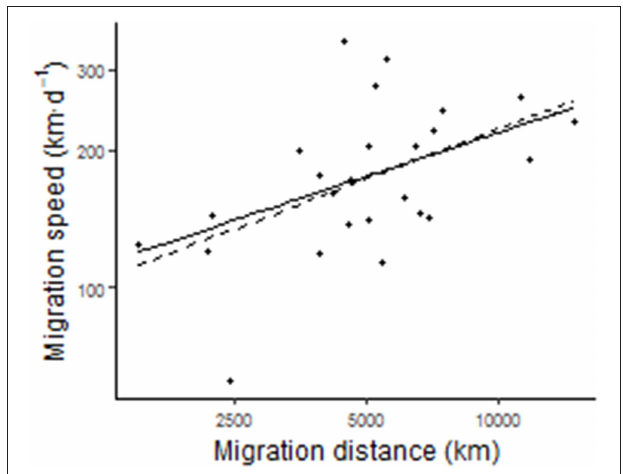
FIGURE 8 | Songbird species with longer migrations have faster migration speeds. The phylogenetically-controlled regression line is shown (solid line) in addition to the least squares regression line (dotted line). Migration speed and distance were log10-transformed in the